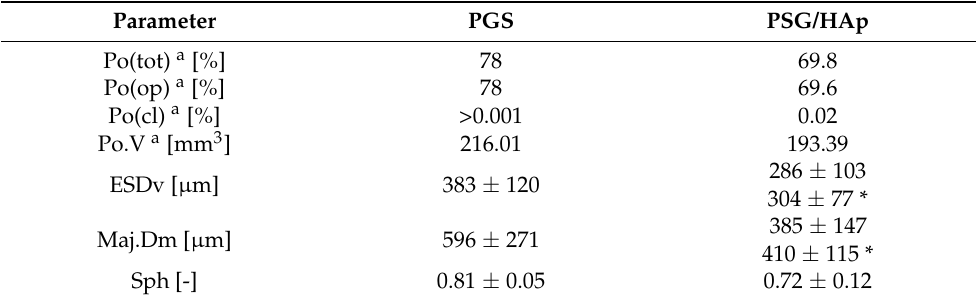
Figure 5. Pore diameter described as ( A ) a volume-equivalent sphere diameter (ESDv), ( B ) major diameter (Maj.Dm), ( C ) sphericity (Sph). Values on the X axis are presented as a bin center. Table 1. The relative density and porosity of the scaffolds and the substrates.